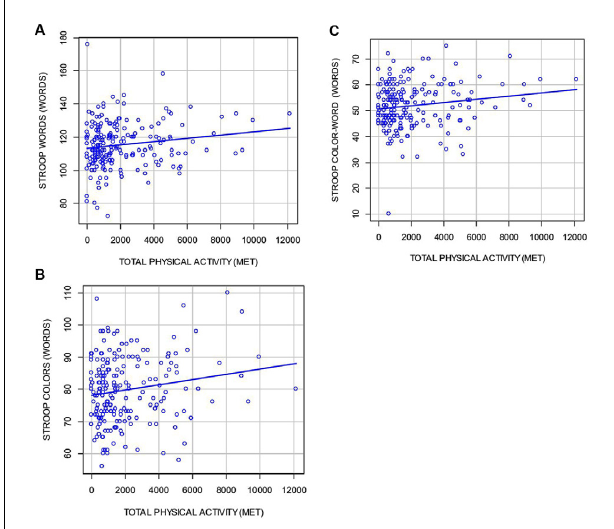
FIGURE 2 | Scatter plot showing Trail making test A results and their correlation with the total amount of METs of PA stratified by